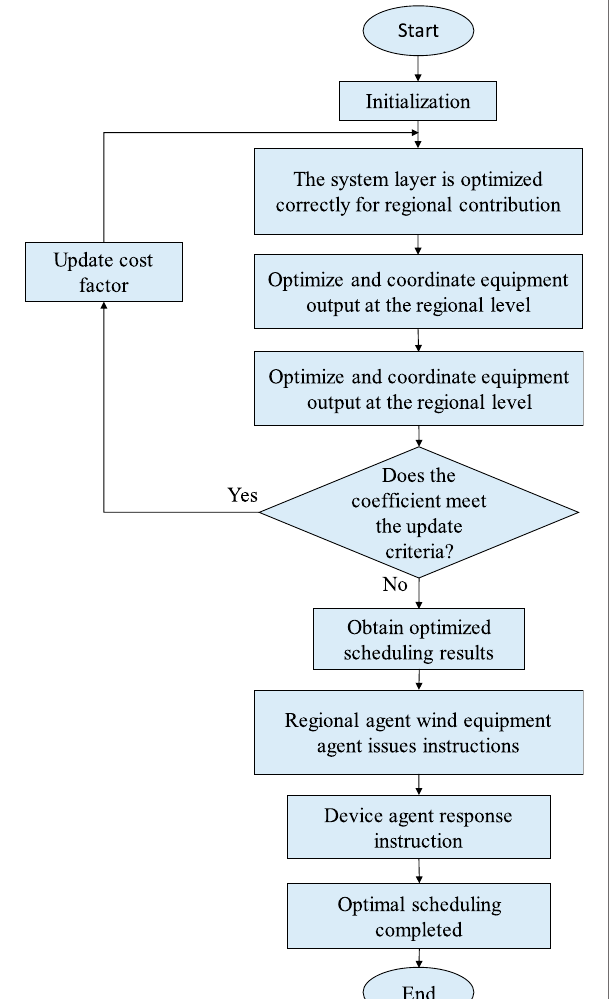
FIGURE 4 | Flowchart of the proposed optimization